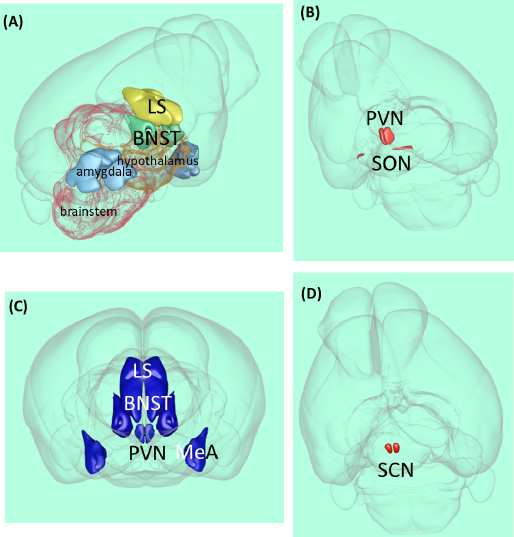
Figure 1. Vasopressin-related brain areas in the rodent brain. ( A ) Localization of the major V1a receptor-containing areas. ( B ) Magnocellular vasopressinergic cells. ( C ) Major parvocellular vasopressinergic cells. ( D ) Suprachiasmatic nucleus. Abbreviations: BNST—bed nucleus of stria terminalis, LS—lateral septum, MeA—medial amygdala, PVN—paraventricular hypothalami nucleus, SCN—suprachiasmatic nucleus, and SON—supraopticus nucleus [29] .